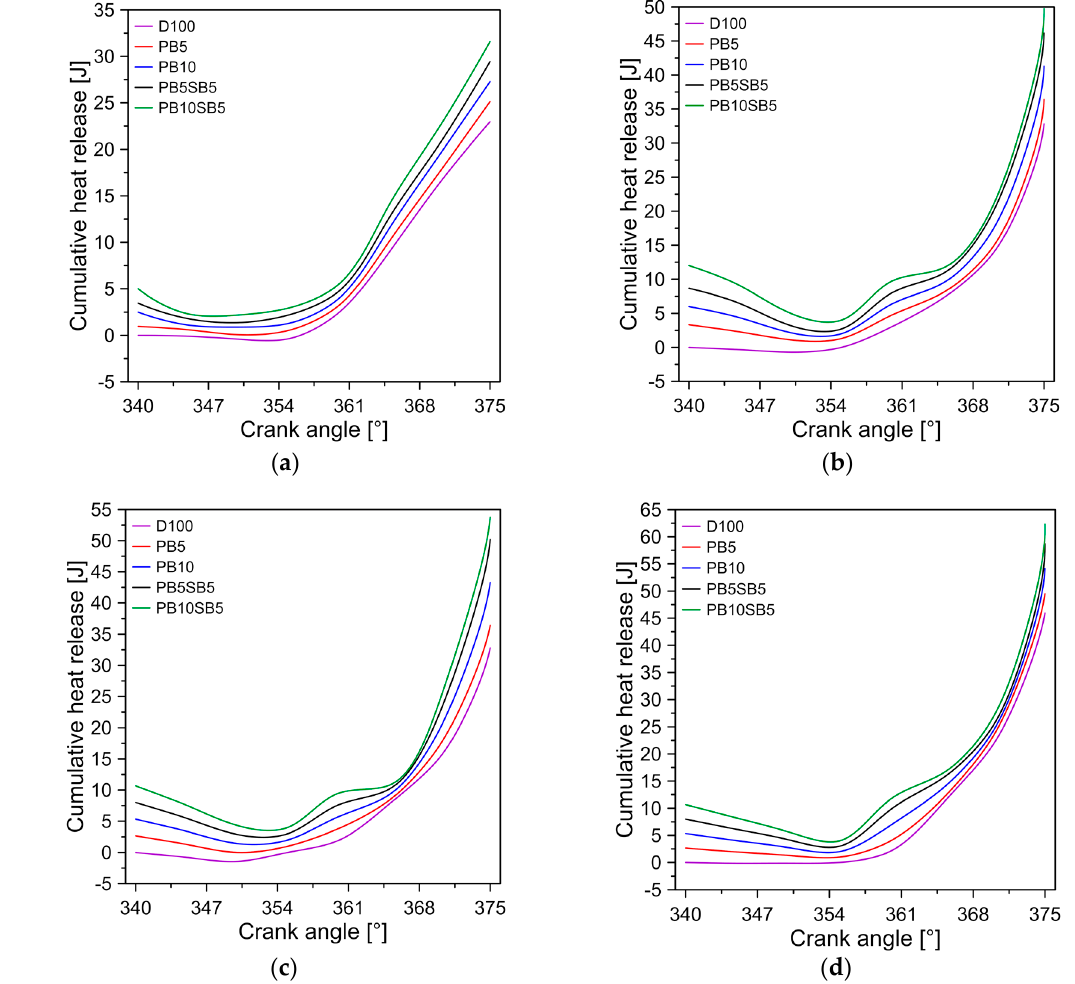
Figure 7. Accumulated heat rate diagram for ( a ) mode A, ( b ) mode B, ( c ) mode C, and ( d ) mode